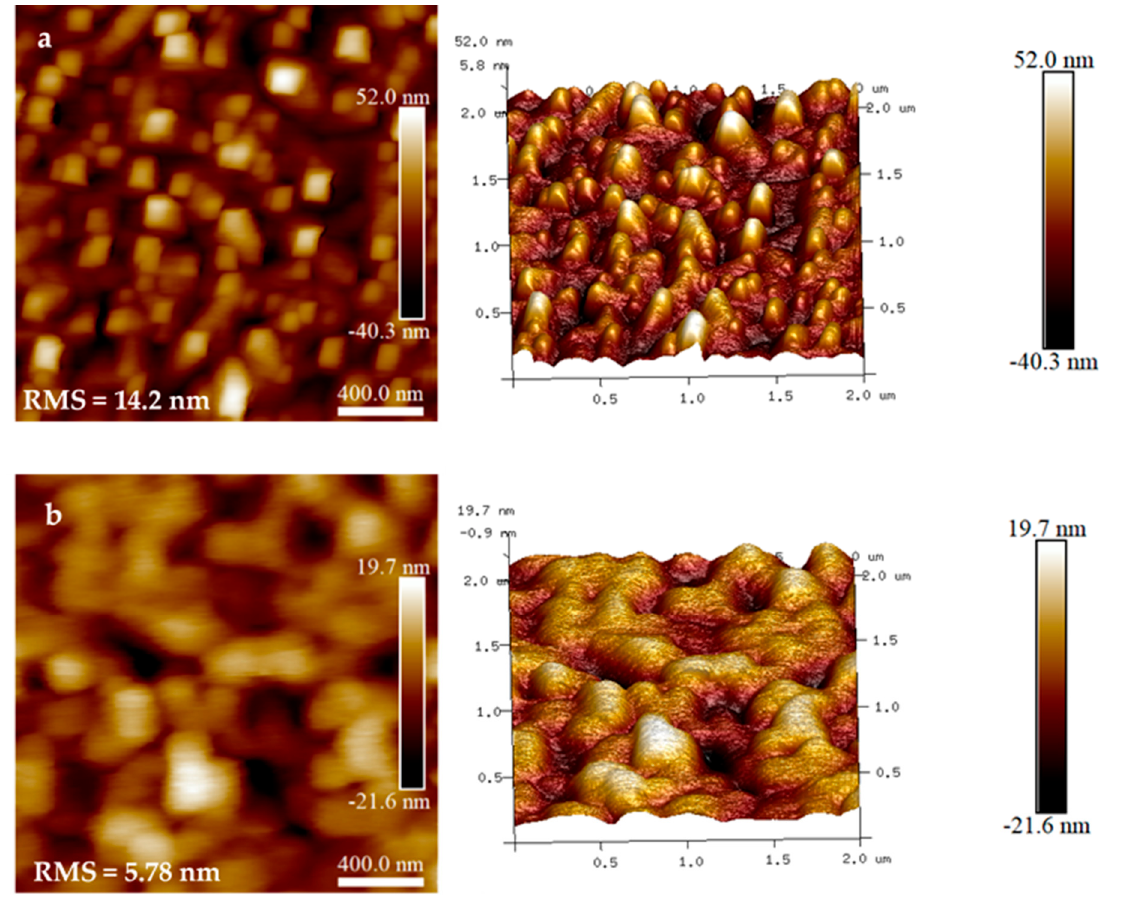
Figure 3. AFM images of spin-coated ( a ) and sprayed ( b ) SnO 2 thin films. We tested the XPS spectra of SnO 2 films prepared by spin-coating and spray. The fit of each peak was represented by the sum of Gaussian (70%) and Lorentz (30%) lines, and the secondary electron background was subtracted by the Sherry function (yellow line in the figure). Figure 4 shows XPS spectra of spin-coated and sprayed SnO 2 films. It can be seen from Figure 4a that the elements contained in both films are Sn and O. The binding energies of the O–Sn 2+ and O–Sn 4+ peaks were 530.1 eV and 530.6 eV, respectively [25]. The 532.43 eV peak of the spin-coated film and the 531.6 eV peak of the sprayed film could be the peak of C=O and the peak of O 2 adsorption [26–28]. By fitting the peak area ratio, it can be obtained that the ratio of O–Sn 2+ /O–Sn 4+ for the spin-coating film is 0.72, and the ratio of O–Sn 2+ /O–Sn 4+ for the spraying film is 0.83. This indicates that the SnO content of the sprayed film is higher, which suggests more oxygen